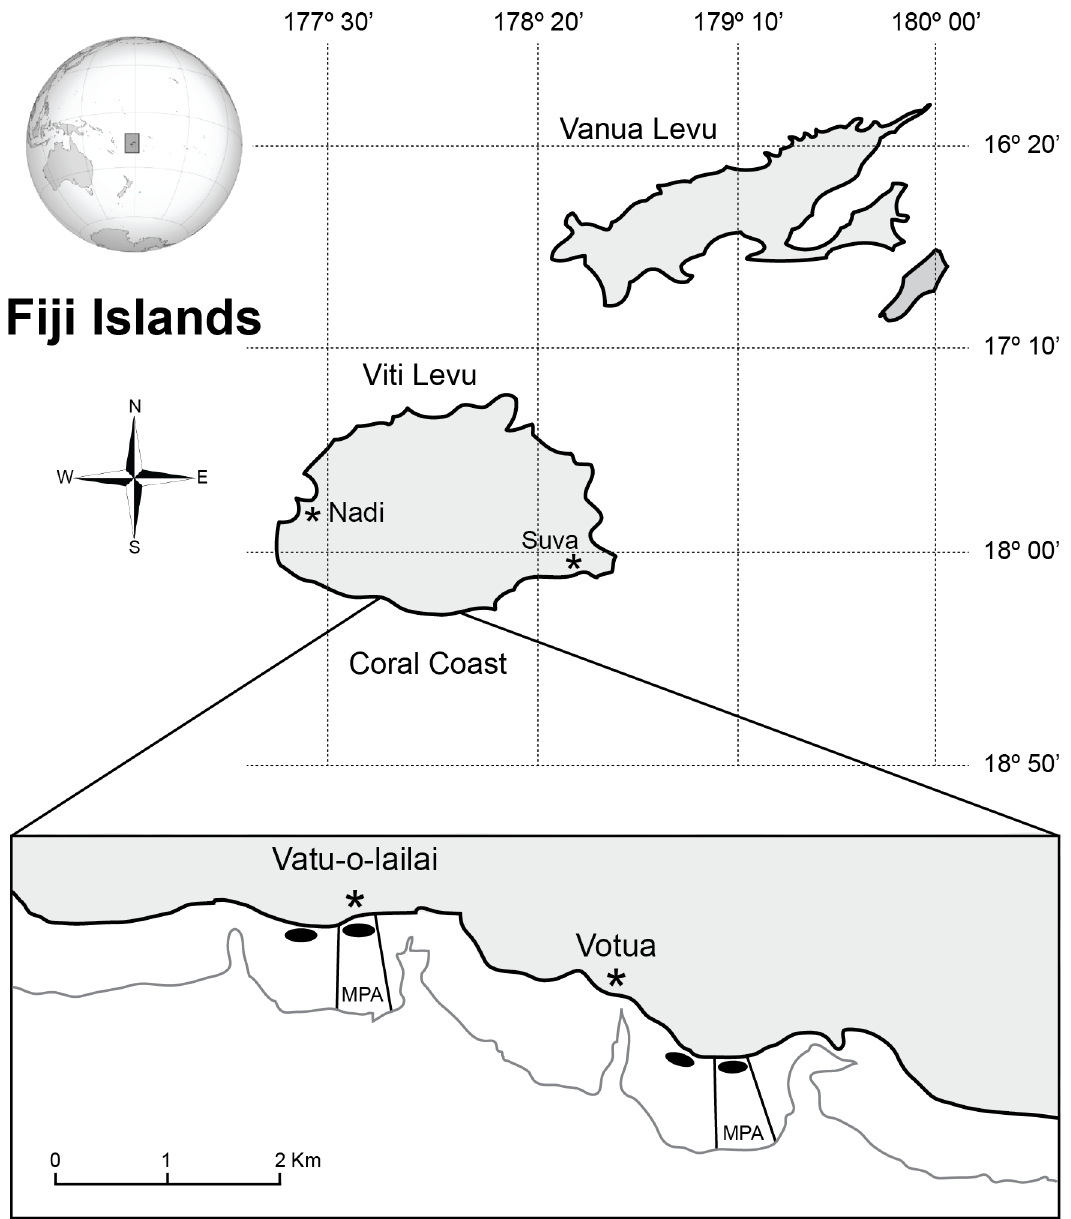
Fig 1. Locations of villages, MPAs, sample collections, and experiments. Ovals represent the area in which samples were collected for microsatellite analysis and where experiments involving caging of mature S . polycystum fronds and transplanting of recruit-sized ramets were conducted. Experiments caging recruit-sized ramets and transplanting adults were run slightly seaward. A portion of the figure modified from [26,